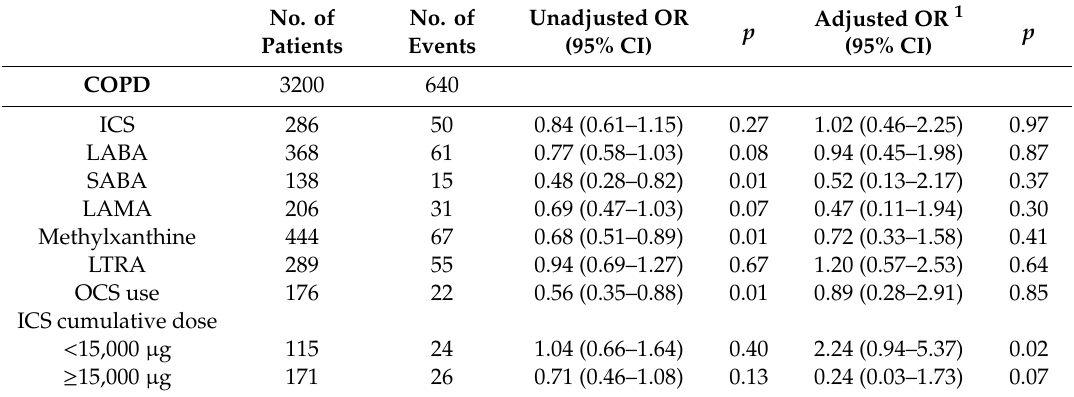
Table 5. Risk of COVID-19 according to drug exposures among patients with COPD and